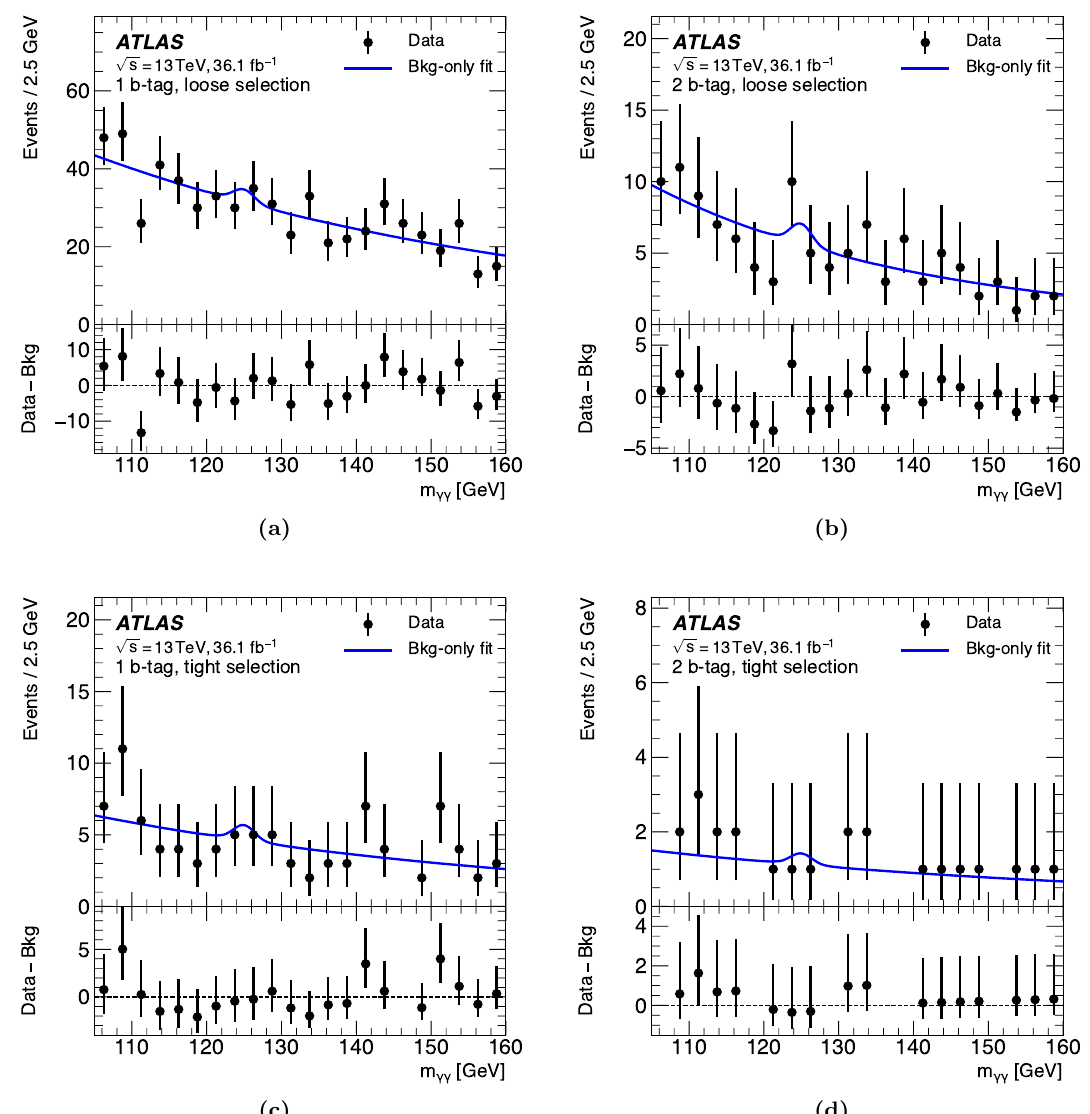
Figure 4. For the non-resonant analysis, data (black points) are compared with the background- only (cid:12)t (blue solid line) for m (cid:13)(cid:13) in the 1-tag (left) and 2-tag (right) categories with the loose (top) and tight (bottom) selections. Both the continuum (cid:13)(cid:13) background and the background from single Higgs boson production are considered. The lower panel shows the residuals between the data and the best-(cid:12)t